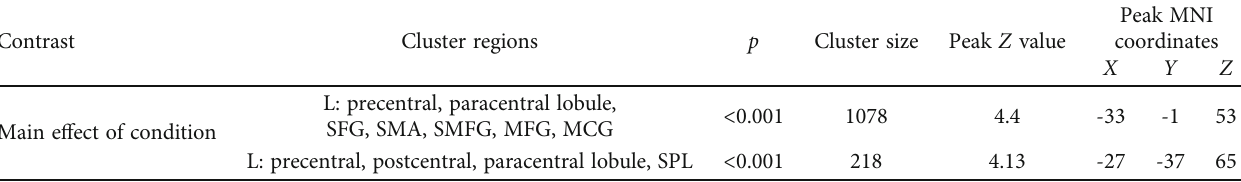
Table 1: Activated brain regions in the functional connectivity analysis.